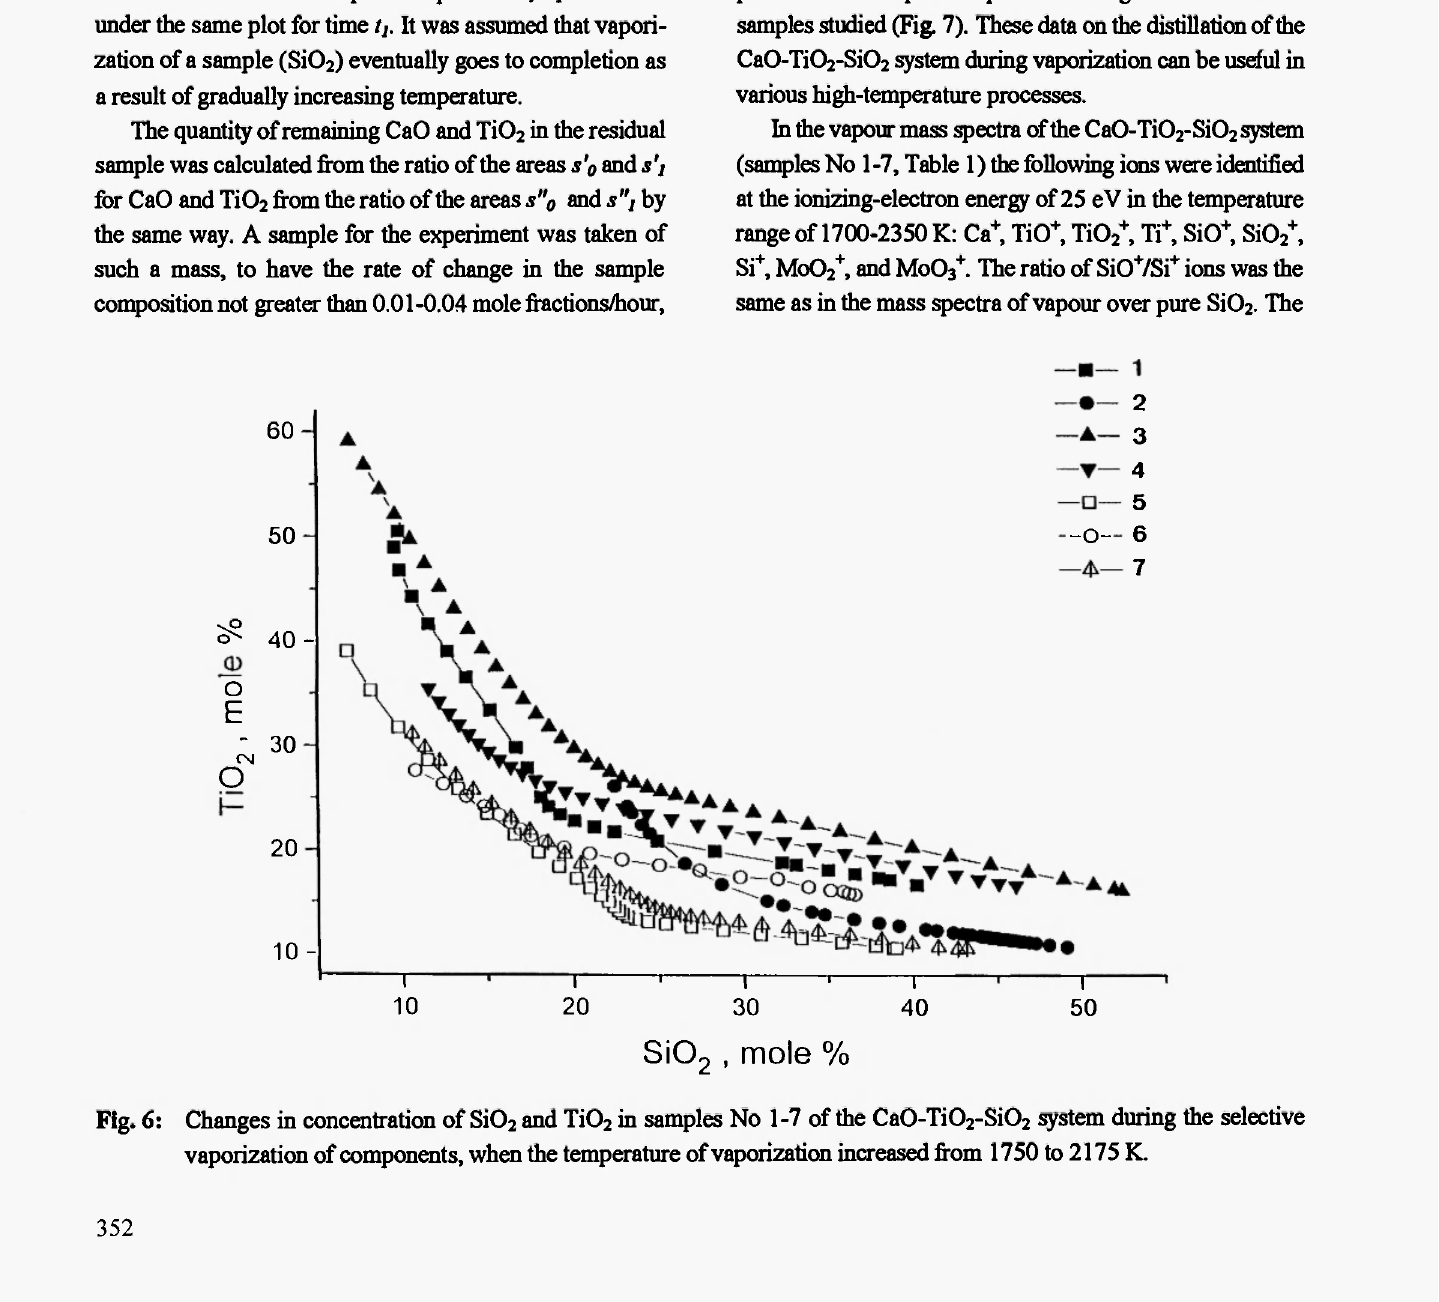
and Ti0 in samples No 1-7 of the Ca0-Ti0 2 2